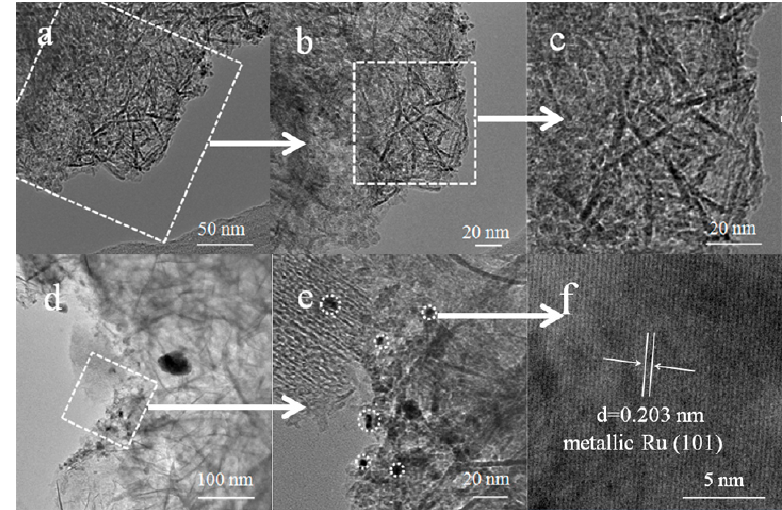
Figure 2. TEM profiles of fresh Ru/Al 2 O 3 ( a – c ) and five ‐ times used Ru/Al 2 O 3 ( d – f ).